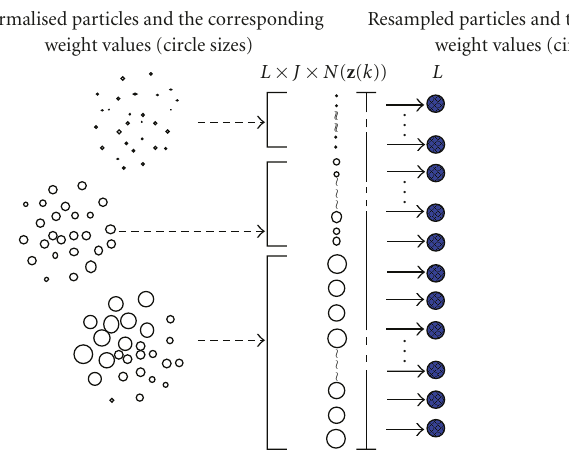
Figure 1: Resampling of L × J × N ( z ( k )) particles to L particles.